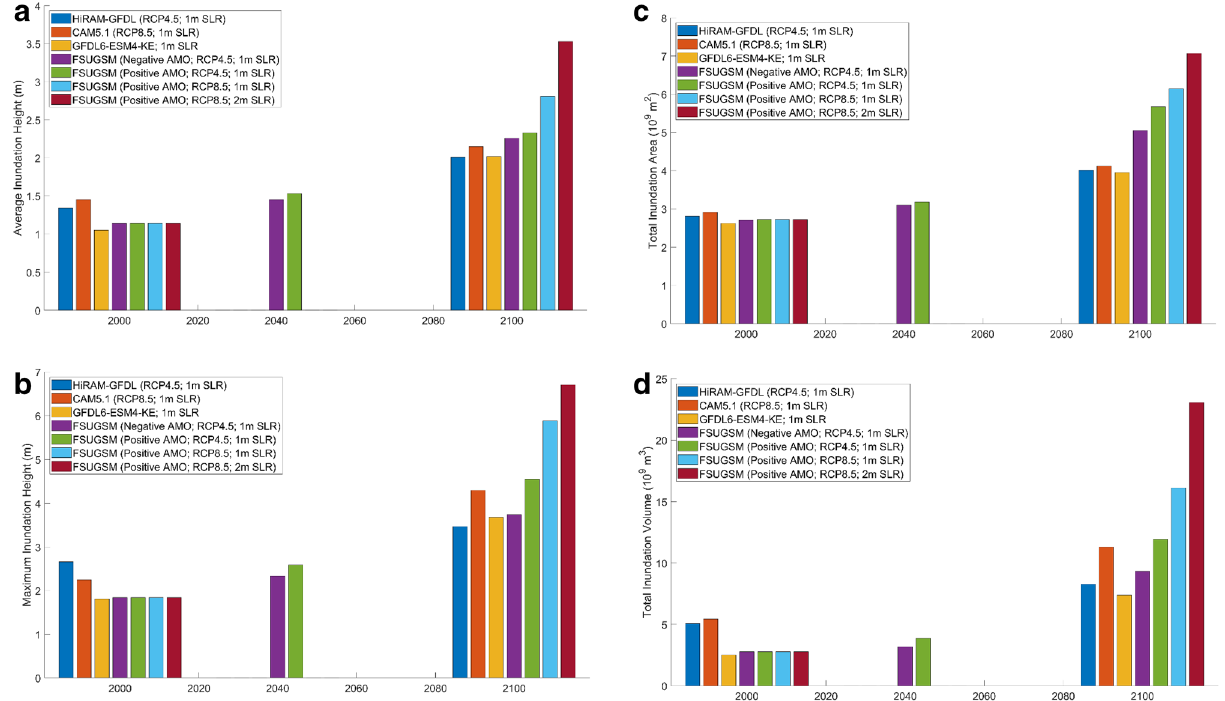
Figure 3. ( a ) Average Inundation Height ( AIH ) of the 1% annual chance flood hazard in SWFL. ( b ) Maximum Inundation Height ( MIH ) of the 1% annual chance flood hazard in SWFL. ( c ) Total Inundation Area ( TIA ) of the 1% annual chance flood hazard in SWFL. ( d ) Total Inundation Volume ( TIV ) of the 1% annual chance flood hazard in